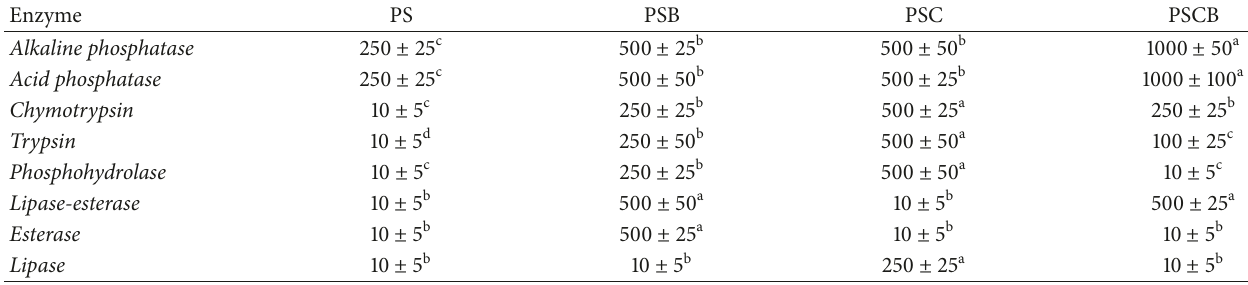
Table 4: Soil enzymatic activities . Soil enzymatic activities were determined by the API-ZYM system (bio-M´erieux Italia). Results are expressed as nanomoles/g of dry weight of substrate; the data have been corrected by the dilution factor. PS = unfertilized soil; PSB = unfertilized soil plus biochar; PSC = unfertilized soil plus compost; and PSCB = unfertilized soil plus compost and biochar. Enzyme PS PSB PSC PSCB Alkaline